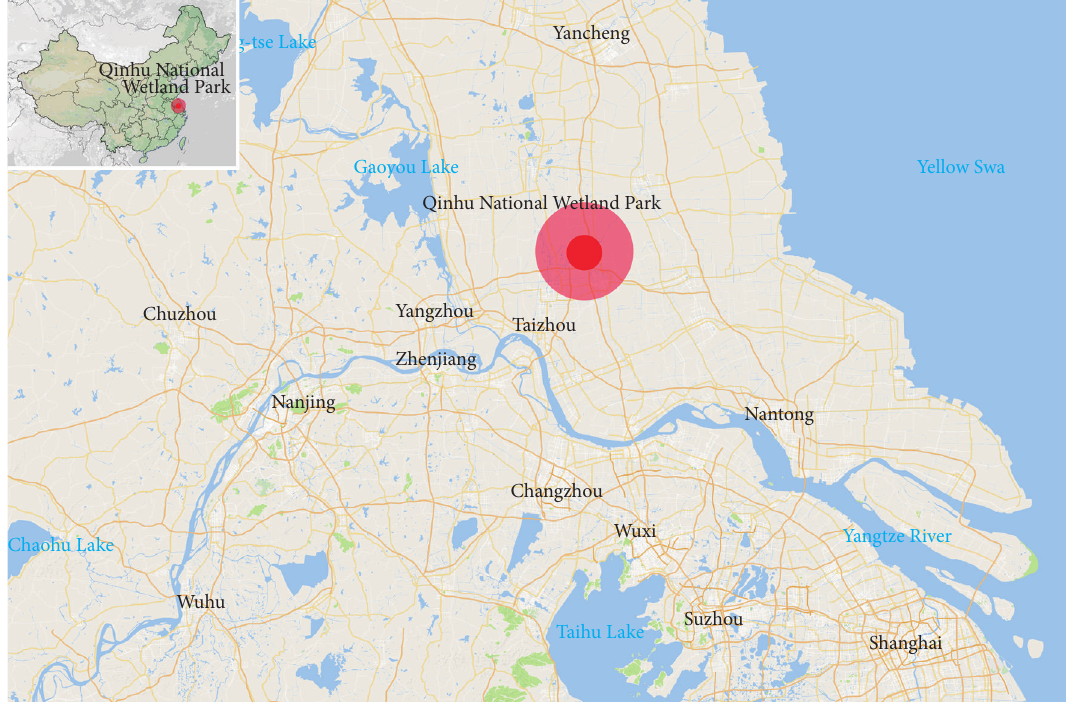
Figure 5: The location map of Qinhu National Wetland